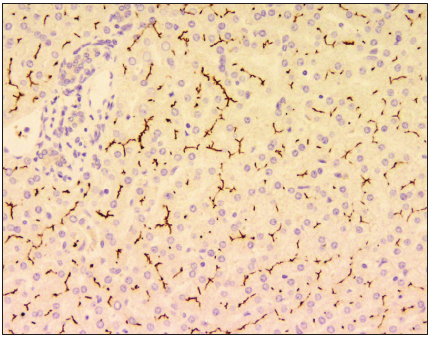
Figure 4: Liver biopsy at 20x magnification, used as a positive control for biopsy in Figure 3. BSEP protein stains are